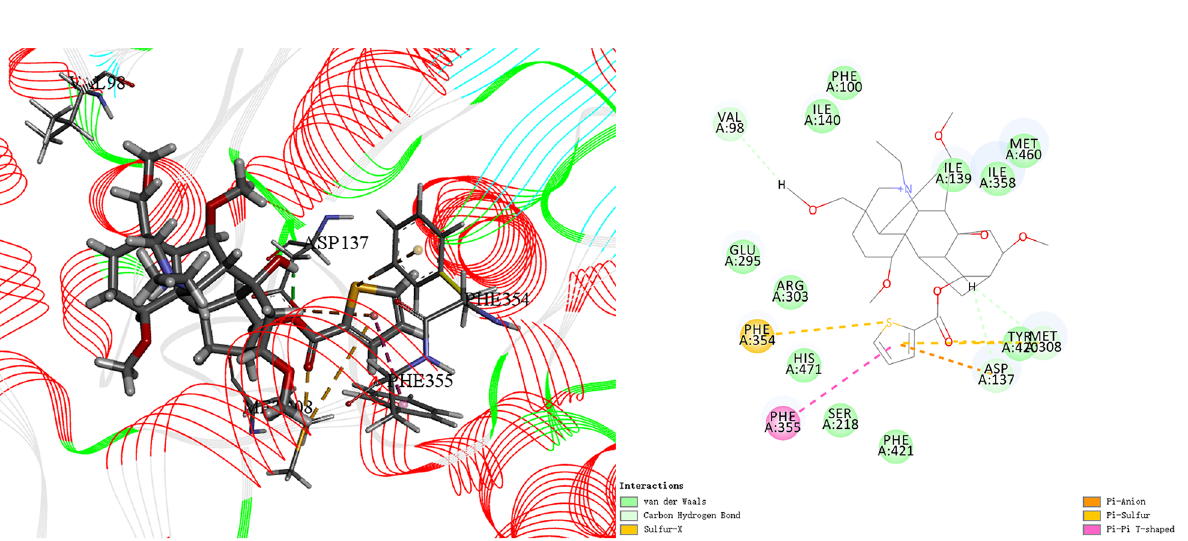
Figure 4. Docking result of receptor-ligand interaction of compound 33 and